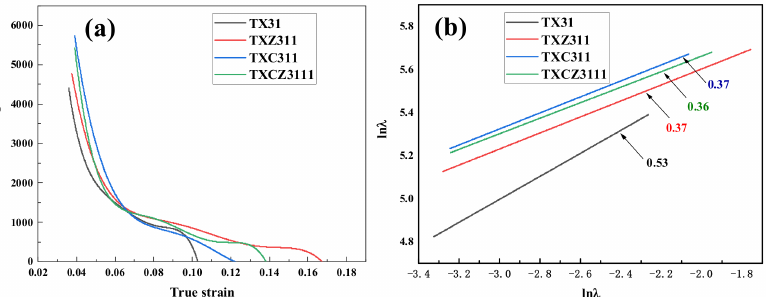
Figure 10. Strain hardening rate ( a ) and strain hardening index ( b ) of four extruded